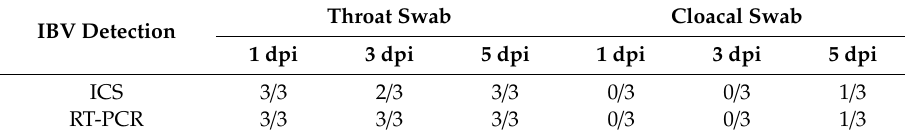
Table 2. Comparison of IBV detection by immunochromatographic strip and RT-PCR. IBV